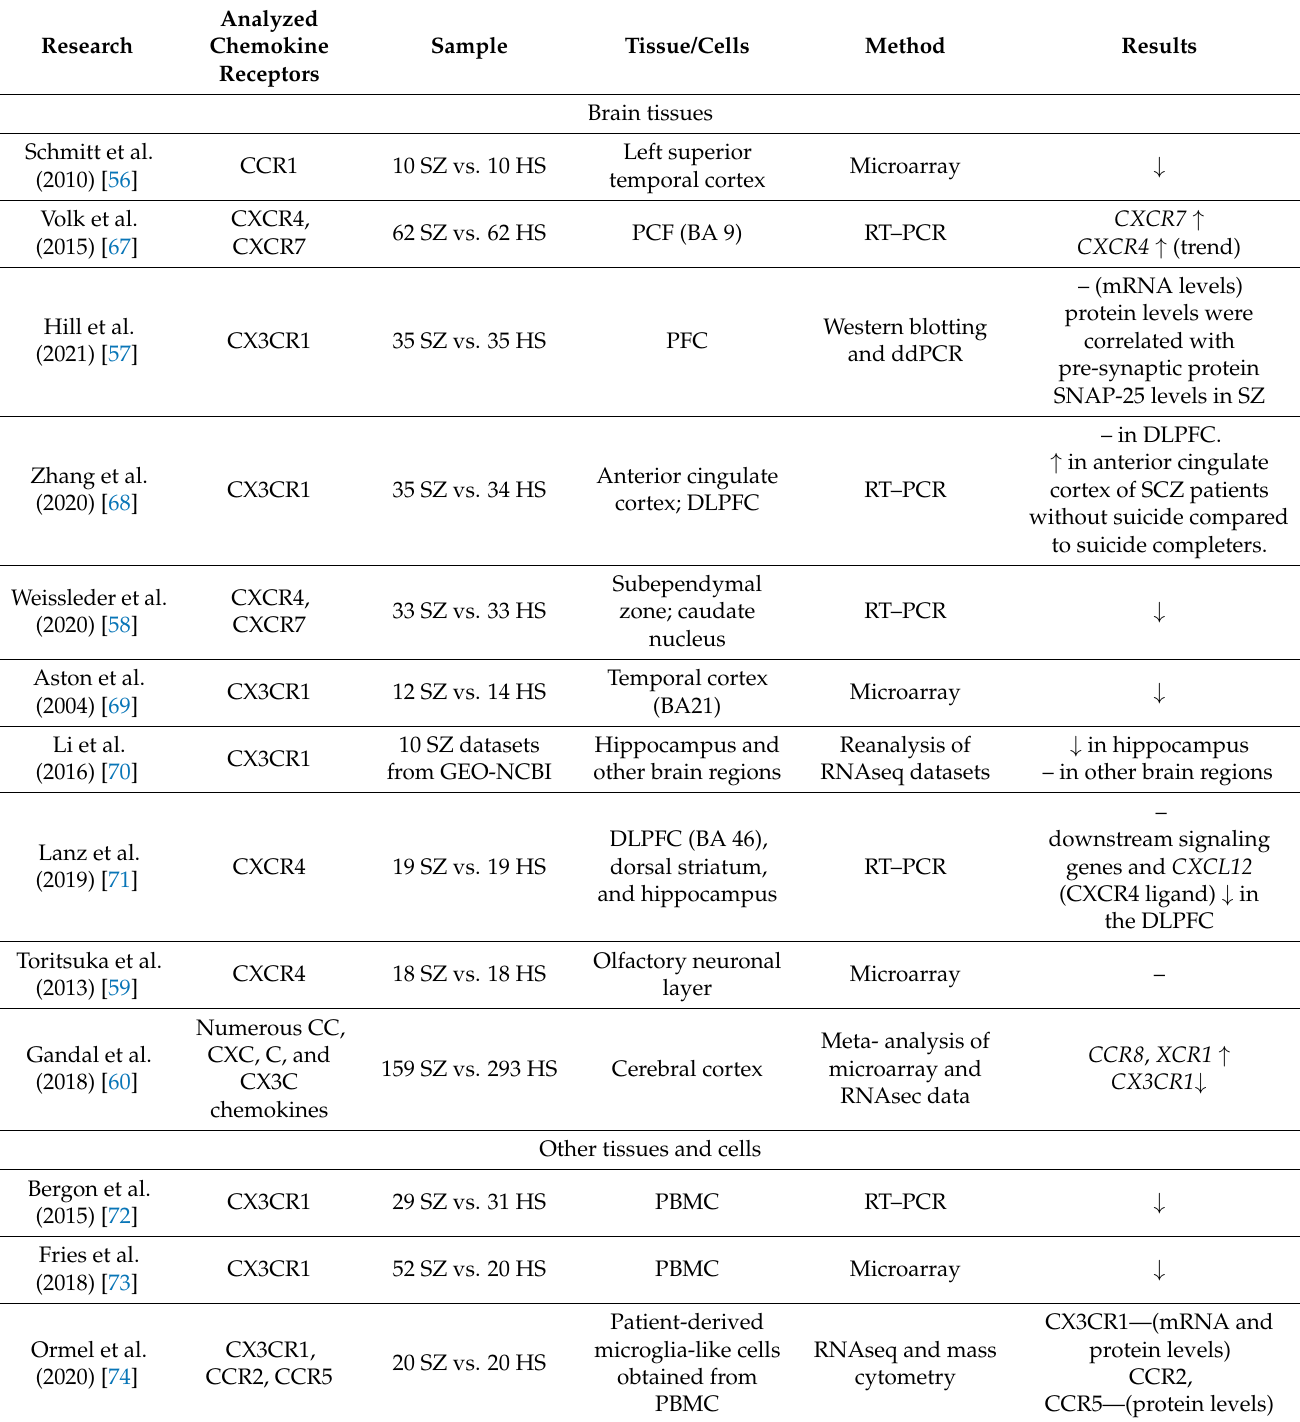
Table 5. Expression of chemokine receptors in the brain and other tissues of patients with